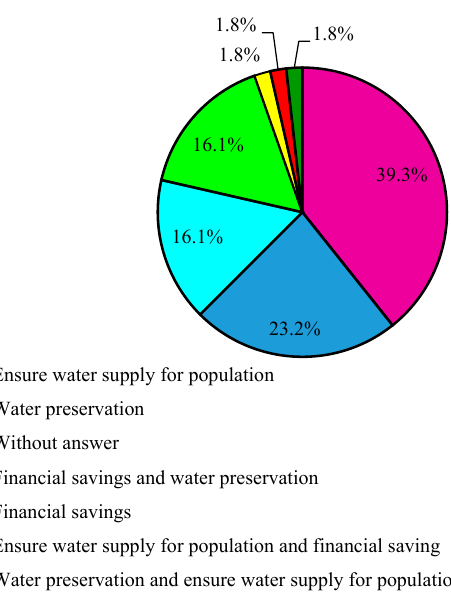
Figure 12. Responses about the purposes of using rainwater harvesting system in the building.